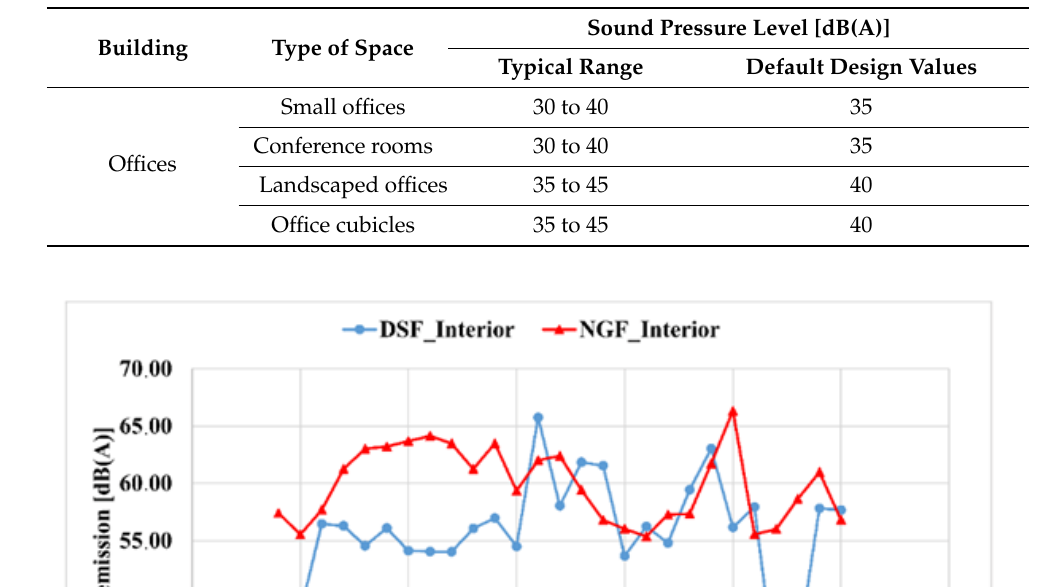
Table 1. Design A-weighted sound pressure levels recommended in SR EN 15251:2007 for office buildings.